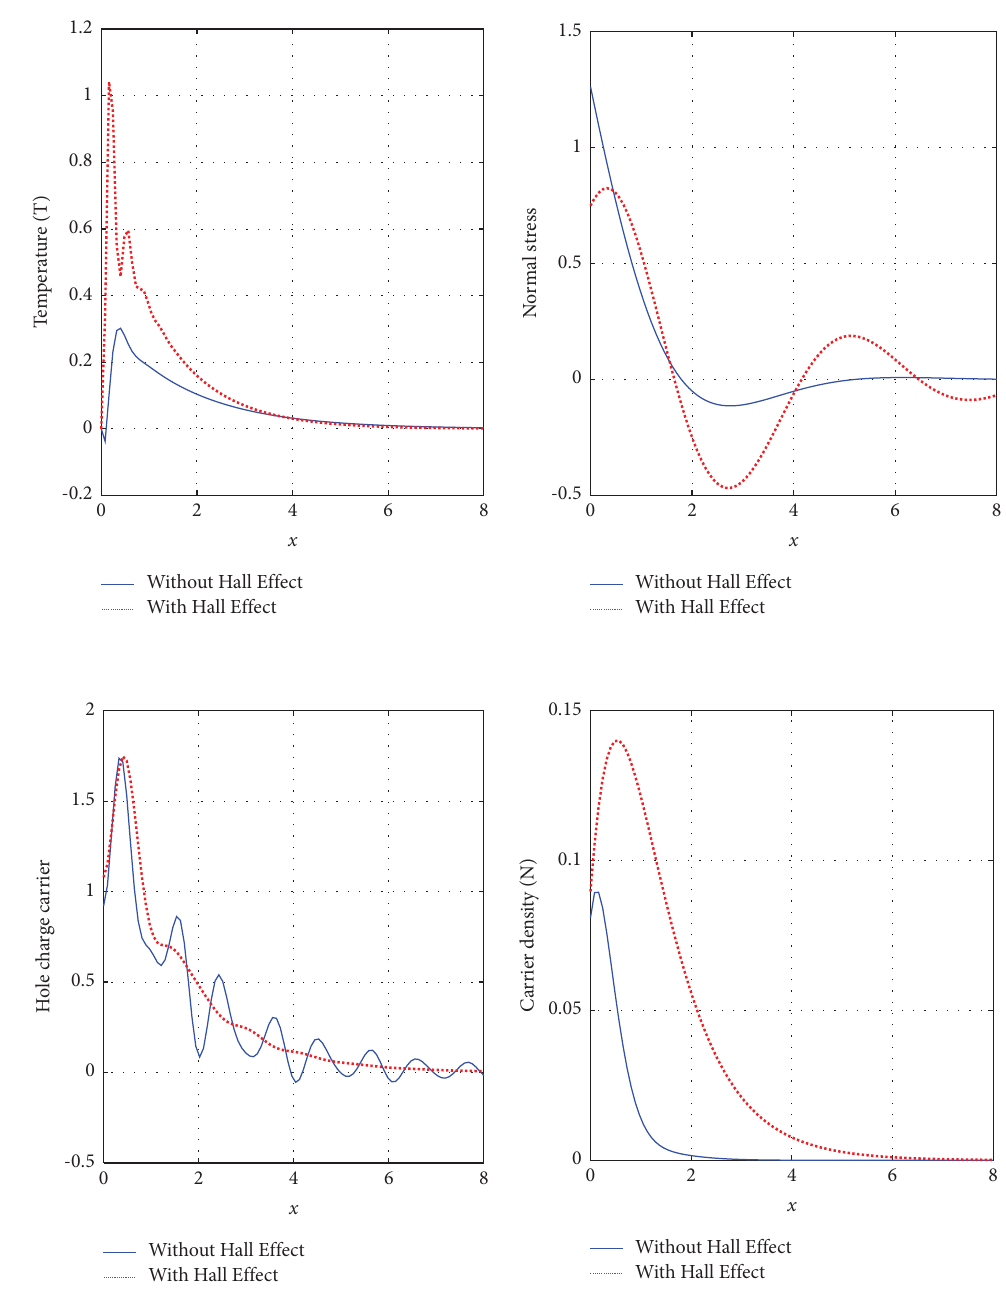
Figure 2: Te variation of physical felds verses the axial distance according to the DPL model with variable thermal conductivity in the absence and presence of Hall